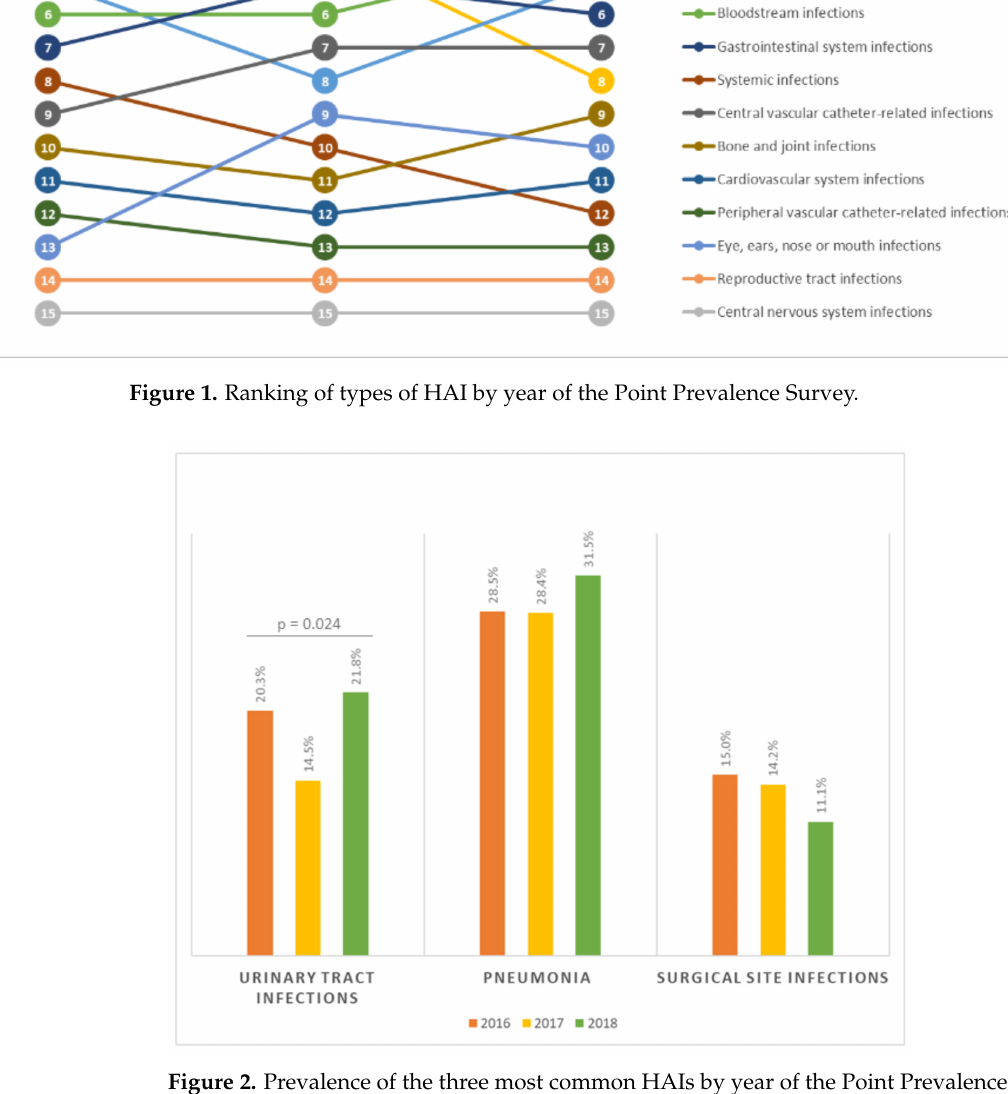
Figure 2. Prevalence of the three most common HAIs by year of the Point Prevalence